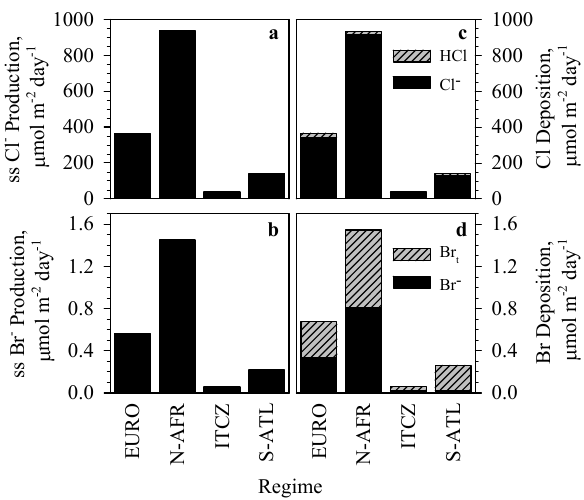
Fig. 6. Median emission fluxes of (a) sea-salt Cl − and (b) sea-salt Br − inferred from dry-deposition fluxes of particulate Na + versus median dry-deposition fluxes of (c) HCl and particulate Cl − , and (d) Br t and particulate Br − for each regime calculated from mea- surements as described in Sect.